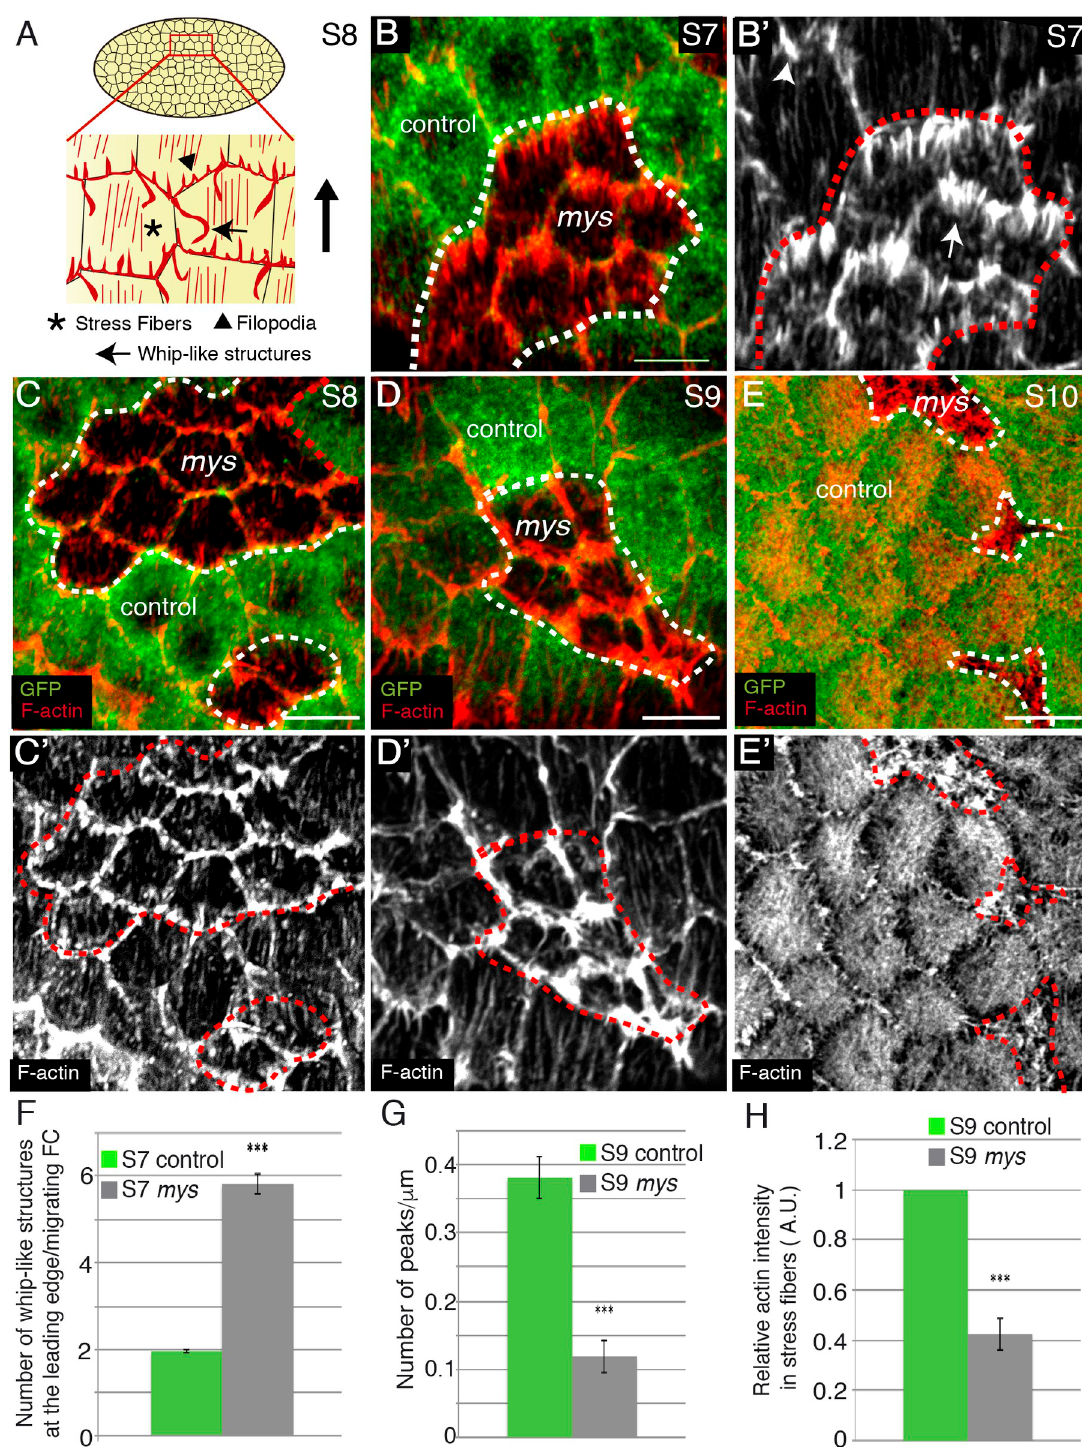
Fig 1. Integrins regulate whip-like structures and stress fibers formation. (A) Schematic drawing of a S8 egg chamber illustrating the different types of actin organisations found on the basal side of FCs. (B-E’) Basal surface view of mosaic S7 (B, B’), S8 (C, C’), S9 (D, D’) and S10 (E, E’) egg chambers containing mys FC clones, stained for anti-GFP (green) and Rhodamine Phalloidin to detect F-actin (red). (B, B’) mys FCs (GFP-negative) contain more whip-like structures (arrow in B’) than control FCs (GFP-positive, arrowhead in B’). (C-E’) Stress fiber number diminishes progressively from S8-10 in mys FCs. (F) Quantification of the number of whip-like structures at